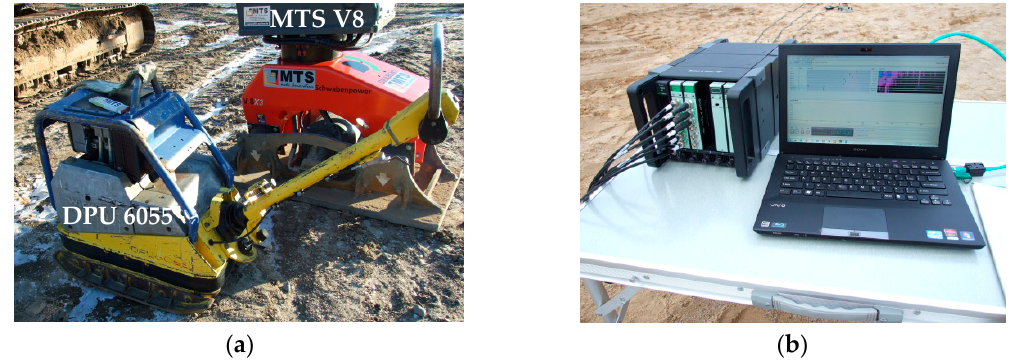
Figure 3. A view of equipment used in the research: ( a ) Reversible plate compactor type DPU 6055 from Wacker Neuson and hydraulic compactor type V8 from MTS; ( b ) Test stand.